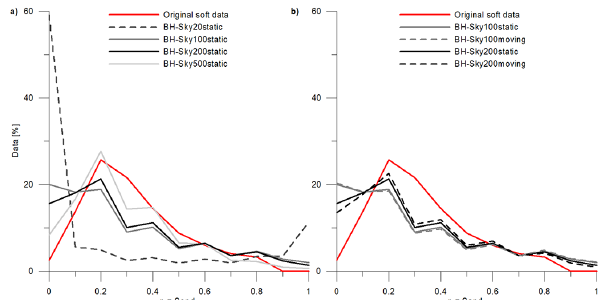
Figure 10. The simulated facies probability distributions based on sets of realizations conditioned to differently sampled soft data sets (based on 25 realizations): (a) static sampling at different sampling distances and (b) stationary and moving sampling at different sam- pling distances. Also shown is the sand probability distribution of the original soft data set which is desired to be reproduced.